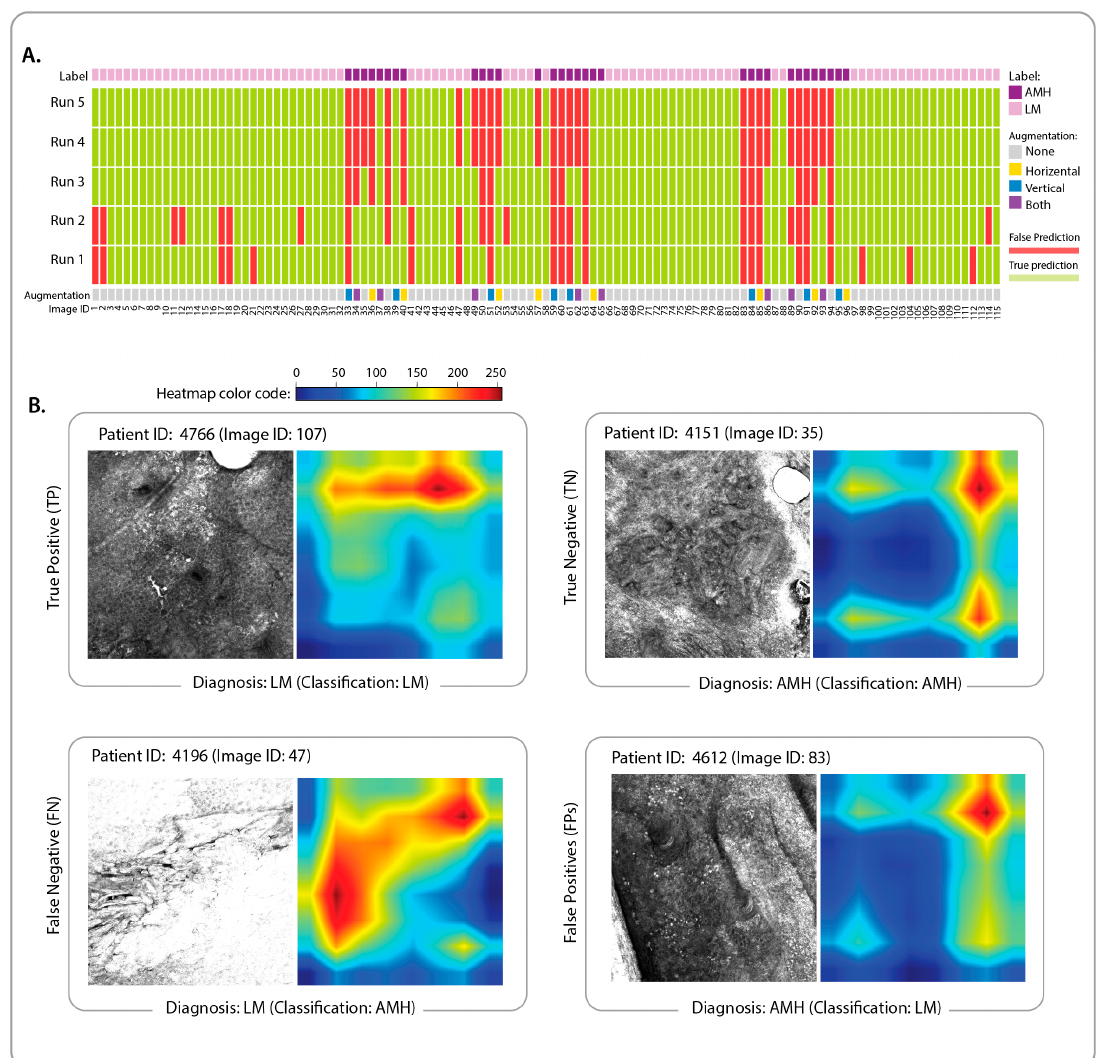
Figure 3. ( A ) Patient-level predictions of LM and AIMP images in the test set across five runs of the cross-validation. The heatmap represents the false predictions (false positives and false negatives) in red and the correct predictions (true positives and true negatives) in light green. Each 2D projection image (equivalent to an RCM stack is identified by a unique ID (Supplementary Table S1) and colour- coded based on the diagnosis (LM or AIMP) and augmentation of the 2D projections (vertical flip, horizontal flip, both, and none, i.e., no augmentation). ( B ) Selected projections in the test set and their corresponding Grad-CAM heatmaps enabling the interpretation of false and true predictions of LM (positive) and AIMP (negative) diagnoses. The colour code is identical for all